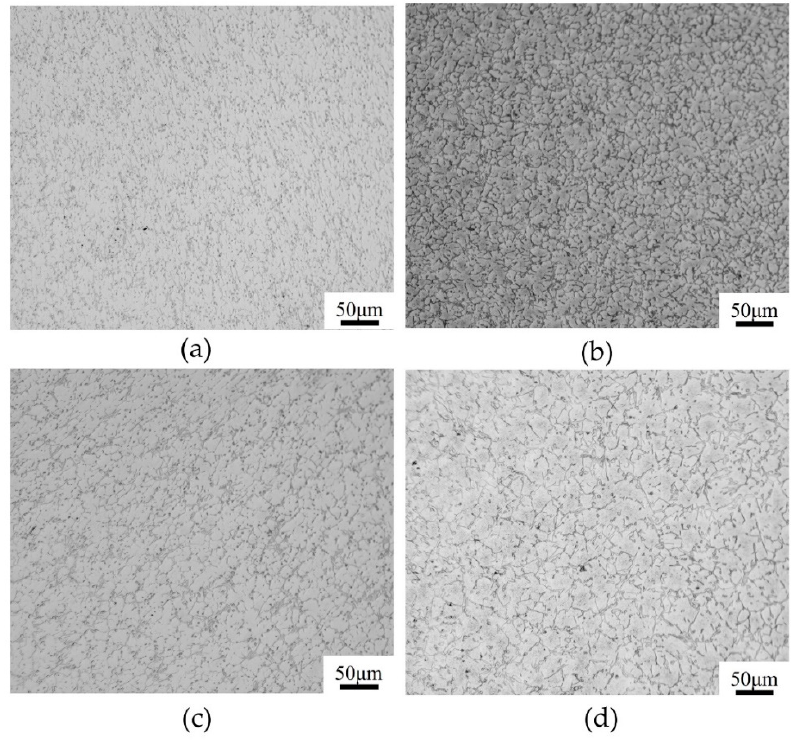
Figure 12. Metallographic structure of T15MN HSS undergoing compression with the strain of 0.9 at a strain rate of 0.1 s − 1 and different deformation temperatures of ( a ) 1273 K; ( b ) 1323 K; ( c ) 1373 K; ( d ) 1423 K.